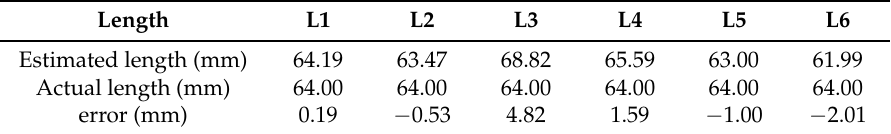
Table 2. Estimated length vs. actual length.